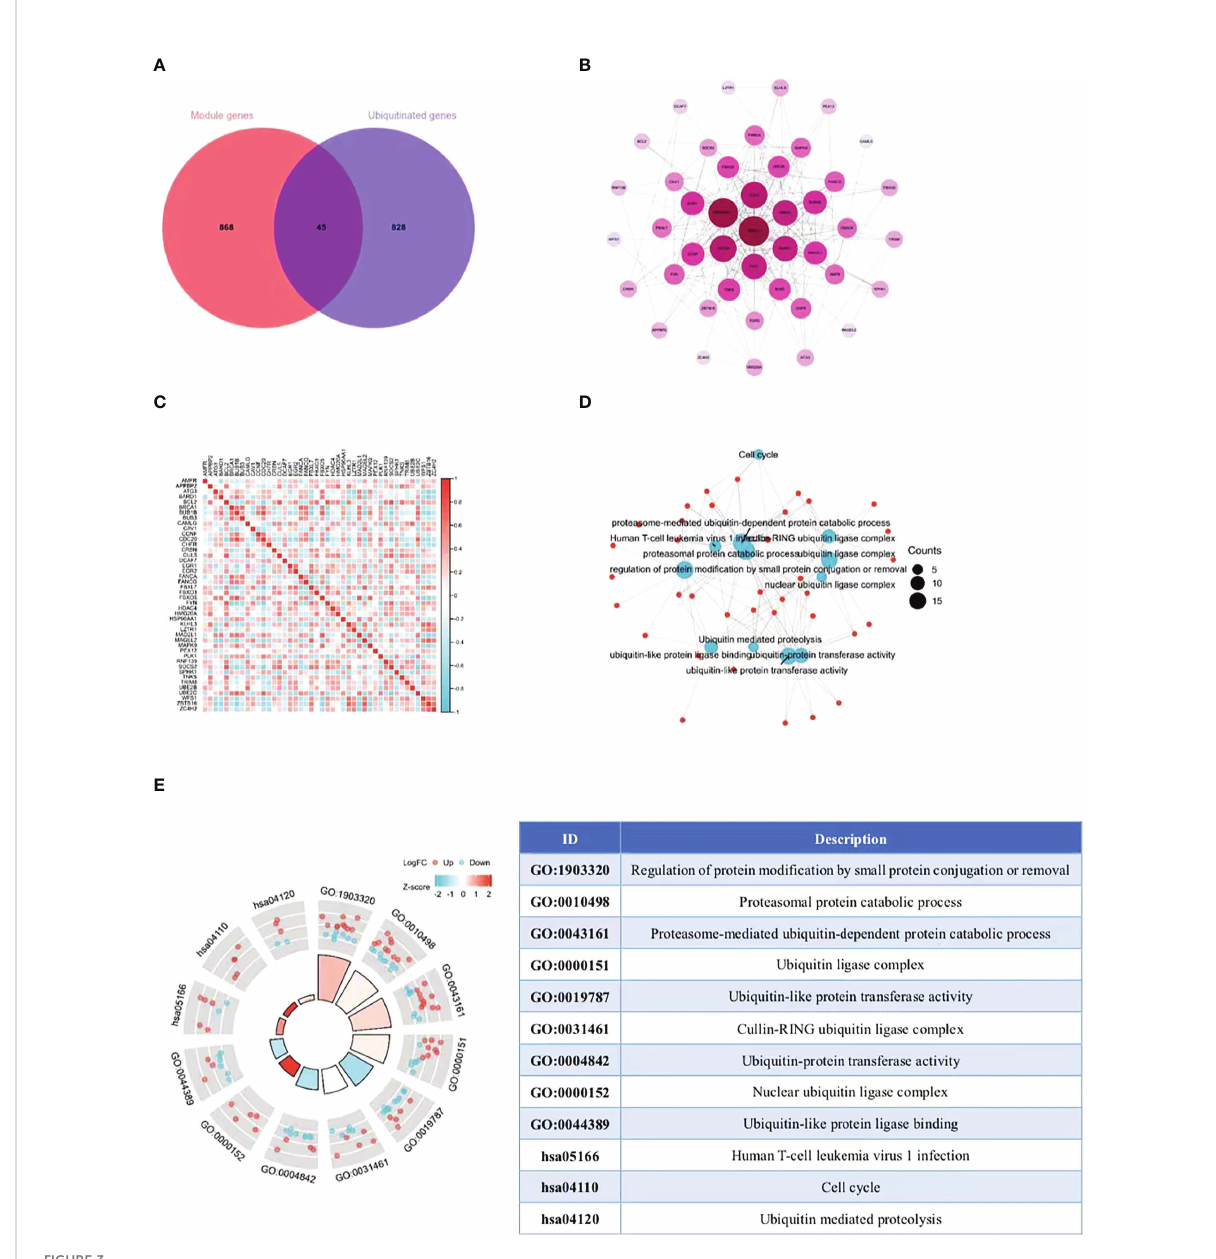
FIGURE 3 Extraction and analysis of ubiquitination-related genes. (A) The Venn diagram of module genes and ubiquitination-related genes. (B) The PPI network of 44 eligible genes. The darker the color, the higher the connectivity of genes. (C) Spearman correlation analysis of the 40 differentially expressed ubiquitination-related genes. (D, E) GO and KEGG analysis of the 40 differentially expressed ubiquitination-related